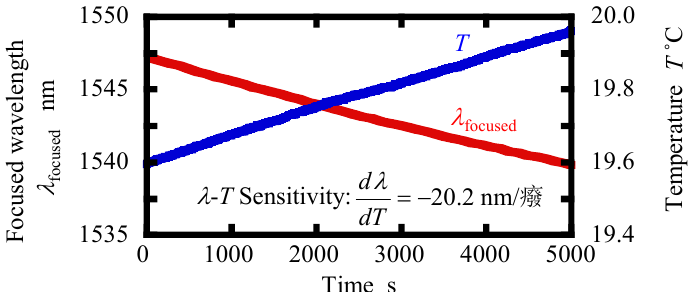
Figure 6. The thermal stability of the focused wavelength λ focused of the overall measurement setup evaluated in the experiment by the setup shown in Figure 2.